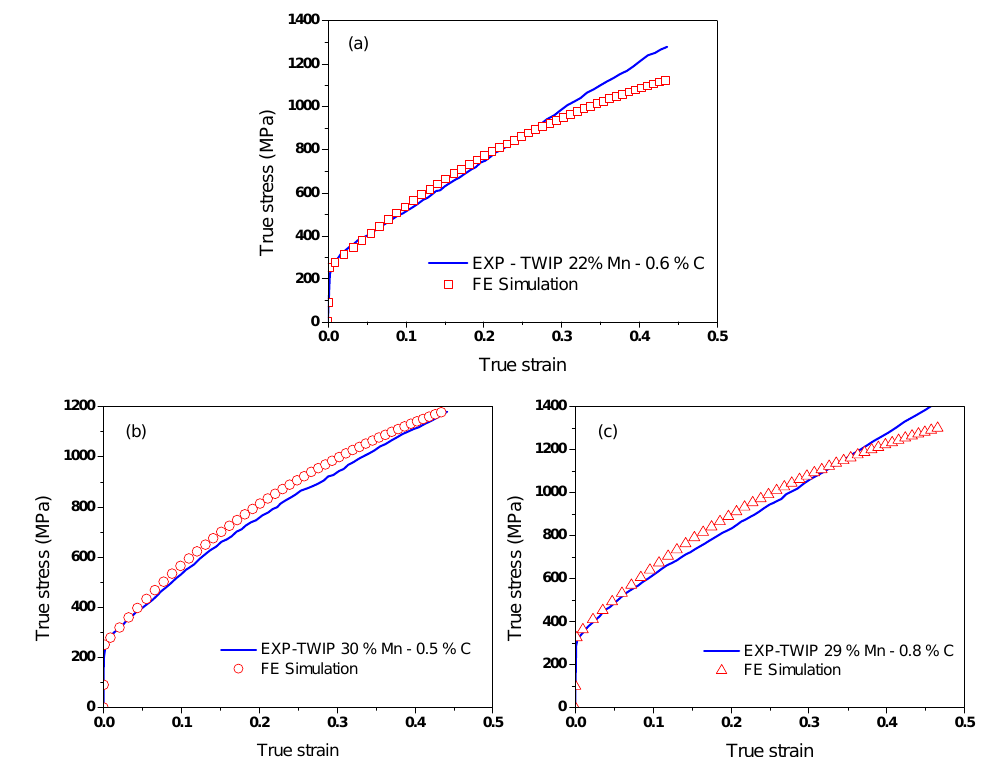
Figure 5. Comparison of experimental and simulation results of TWIP steels subjected to uniaxial tension: ( a ) TWIP 22% Mn-0.6% C, ( b ) TWIP 30% Mn-0.5% C, ( c ) TWIP 29% Mn-0.8%